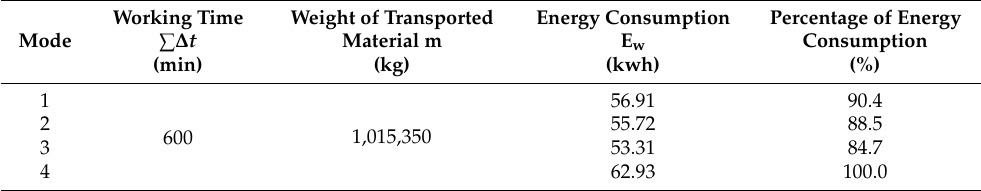
Table 5. Bucket conveyor operation parameters